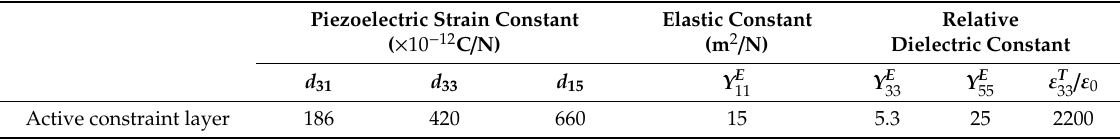
Table 2. Performance parameter of the pipeline with ACLD patches.